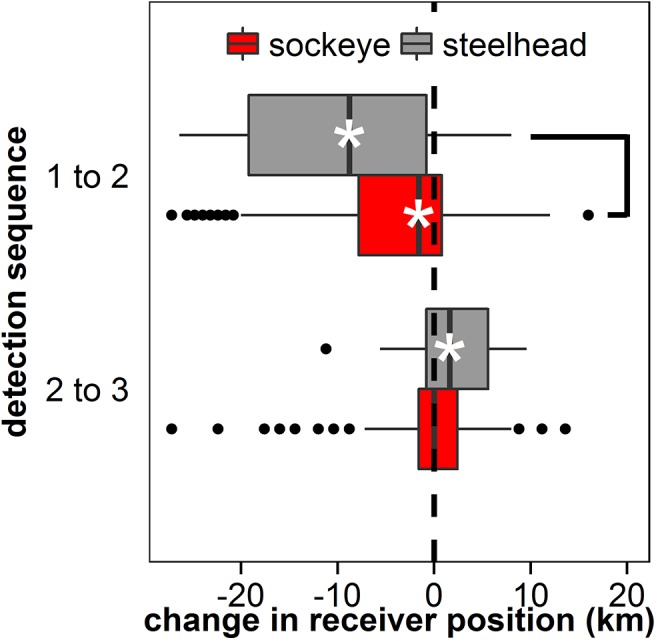
Differences in position (km) of sockeye (red) and steelhead (grey) smolts at the northern Strait of Georgia (NSOG) array between detection sequences.(1) Between first and second detection sequences, and (2) between second and third detection sequences. Negative values indicate westward movements, and positive values indicate eastward movements. Asterisks indicate significant differences from zero (Wilcox-signed rank test). Lines indicate significant differences in change in position between species (black; Wilcox signed-rank test). As described in the Materials and Methods, the change in receiver position for any movements that spanned Texada Island were adjusted by 8 km.